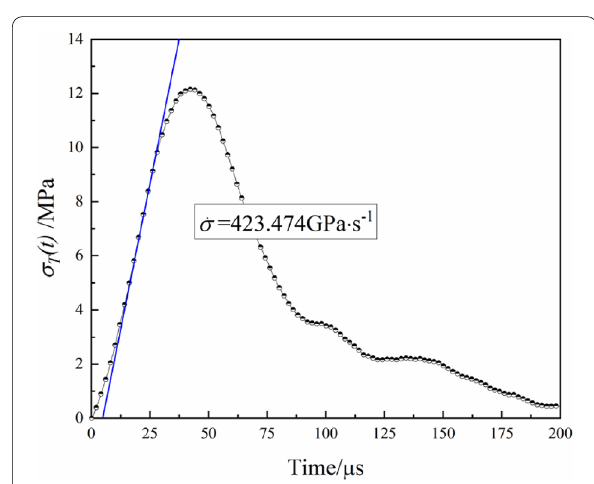
Fig. 5 Determination of loading rate of typical specimen